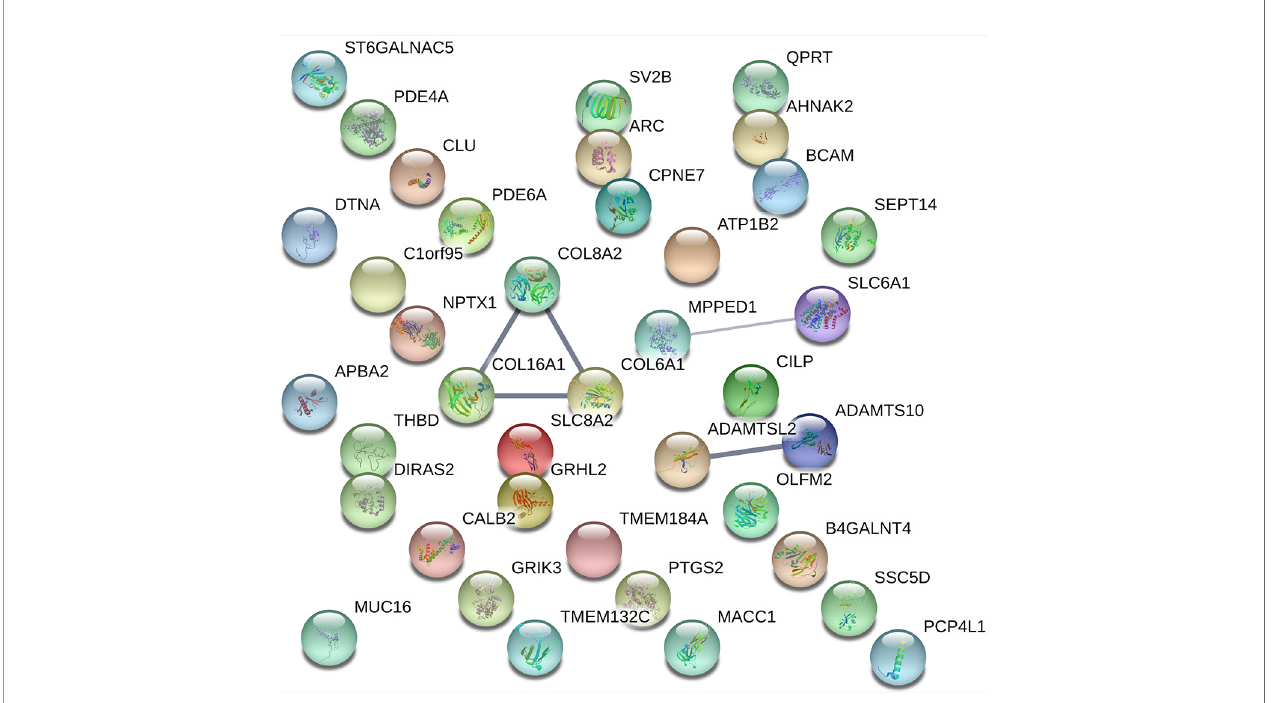
FIGURE 3 | Visual representation of protein – protein interaction enrichment analysis between the statistically signi fi cant 39 out of 40 DEGs using STRING ( v11.0 ) database. The line thickness between the connected nodes indicates the strength of the supporting data. Experiments, databases, co-expression, neighborhood, gene fusion, and